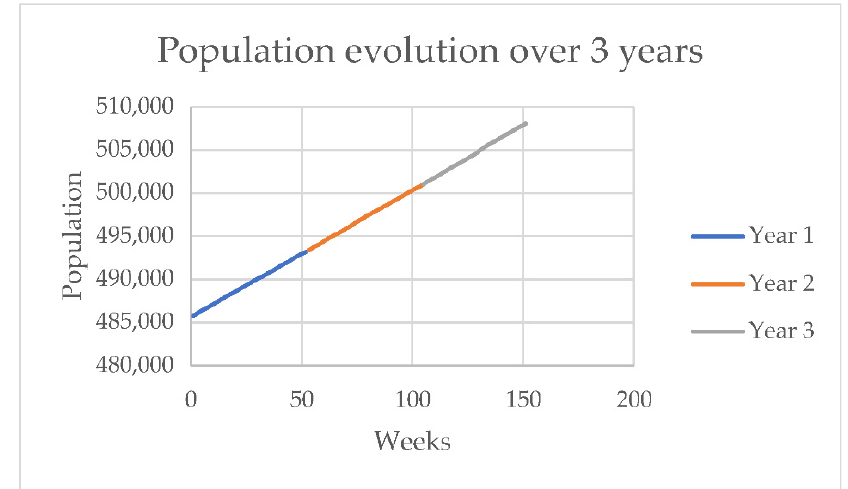
Figure 1. Population evolution over 3 years. Table 4. Population results for each year of the simulation.